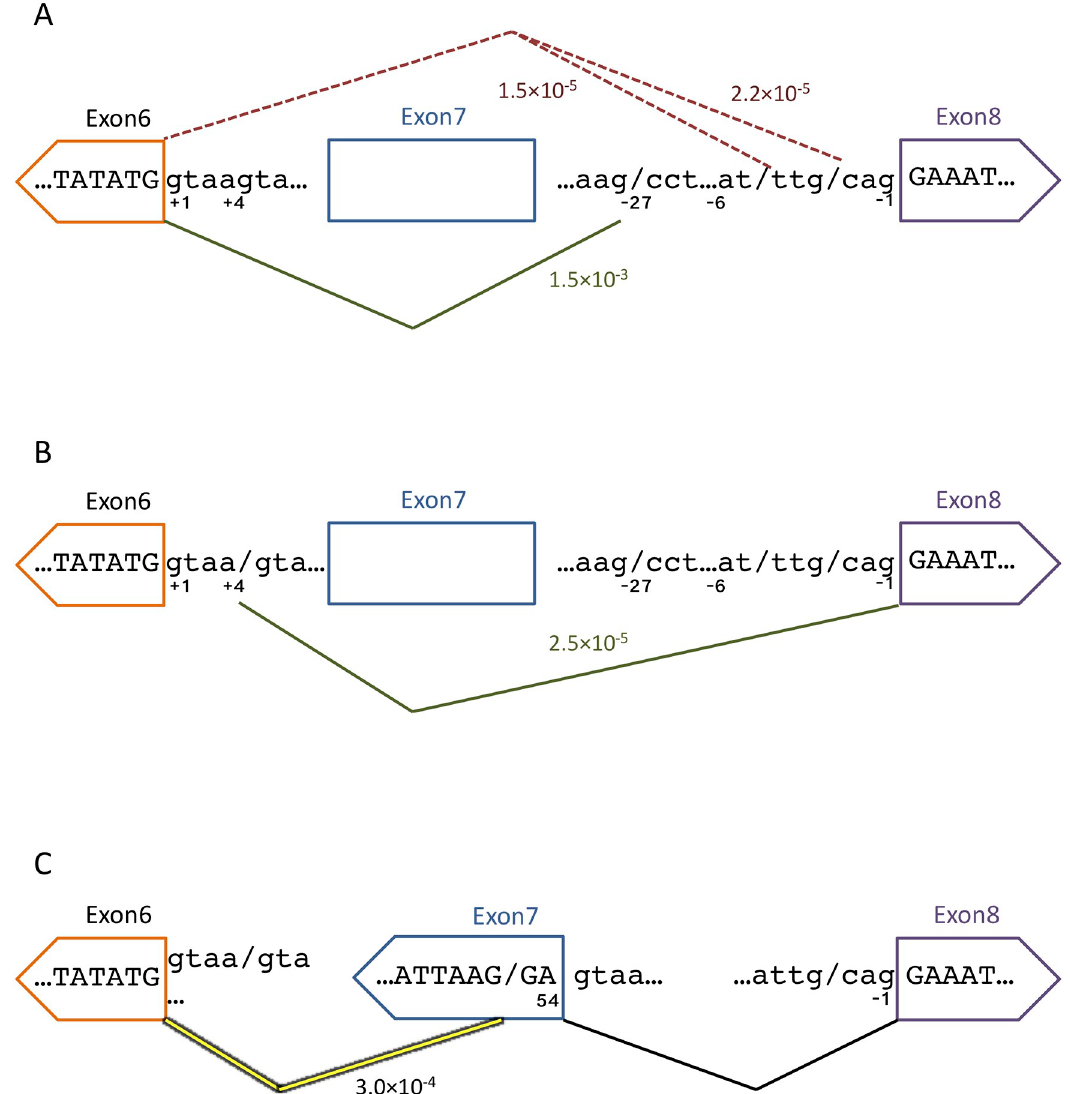
Fig 6. Non-canonical splice site usage with excluded exon 7. A) Non-canonical 3’SS usage between exon 6 and exon 8. The green line represents the unannotated non-canonical 3’ SS event 27 nucleotides upstream of the canonical intron7|exon8 junction. The red dashed line represents the non-canonical splicing observed that is due to transcription or library generation errors resulting in canonical AG dinucleotide sequences. B) Non-canonical 5’ SS usage between exon 6 and exon 8. The green line represents the usage of the intrinsic non-canonical 5’ SS . C) Recursive splicing resulting in GA dinucleotide insertion between exon 6 and exon